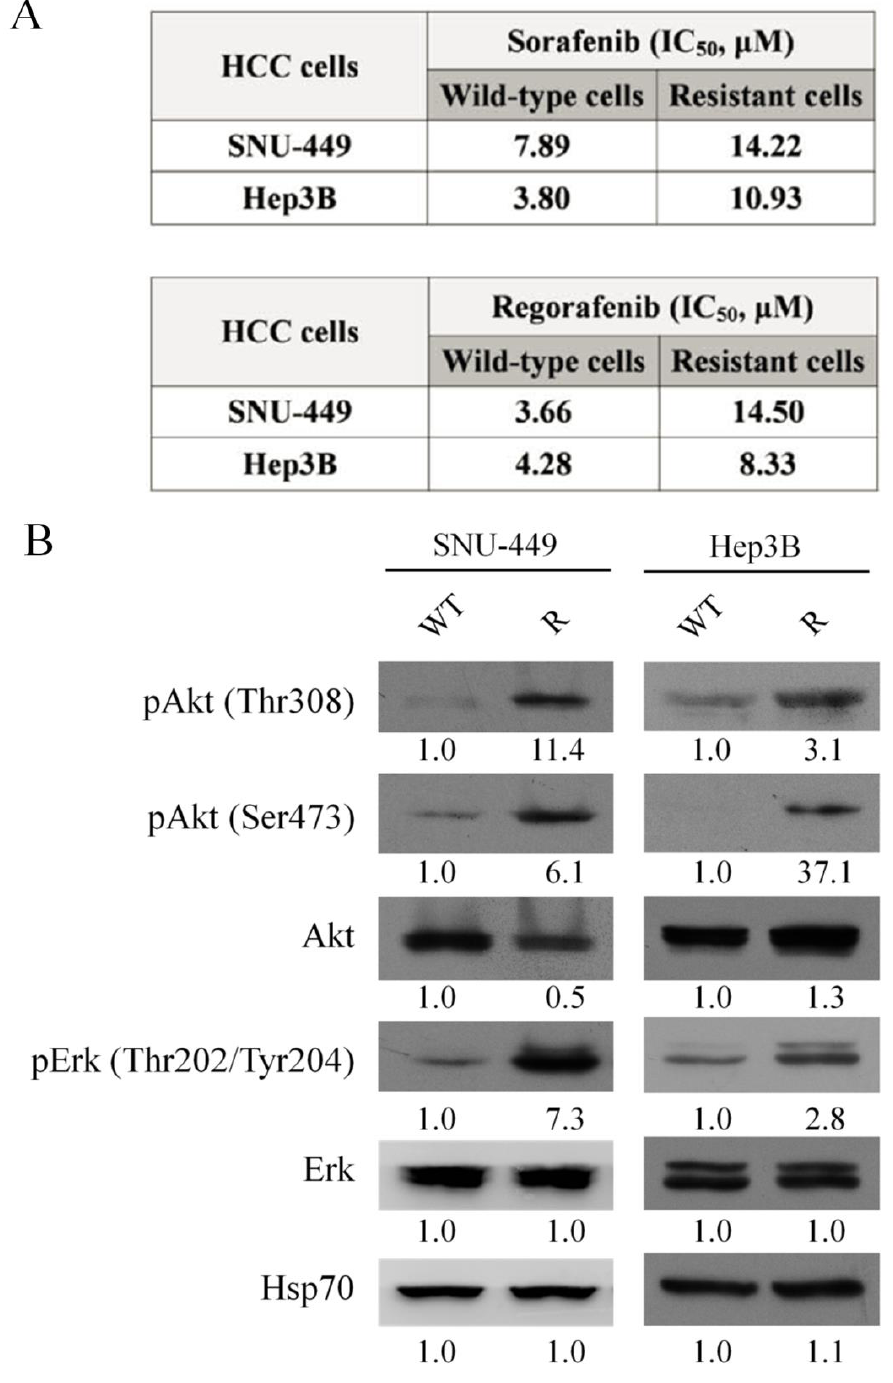
Figure 2. Establishment of sorafenib-resistant HCC cells. HCC cells were subjected to steadily increasing concentrations of sorafenib, with culture starting at 8.3 µ M (IC 50 for SNU-449 cells) or 3.7 µ M (IC 50 for Hep3B cells) sorafenib, and exposure dose increasing by 0.5 µ M each week: ( A ) IC 50 of various cell lines responding to sorafenib or regorafenib. Cell viability was determined by MTS assay. ( B ) Expression of phosphorylated Akt, Akt, phosphorylated Erk, and Erk analyzed by western blotting in WT and sorafenib-resistant (R) cells. Numeric values listed below the bands represent the indicated protein expression by densitometry analysis relative to levels in the WT cells.